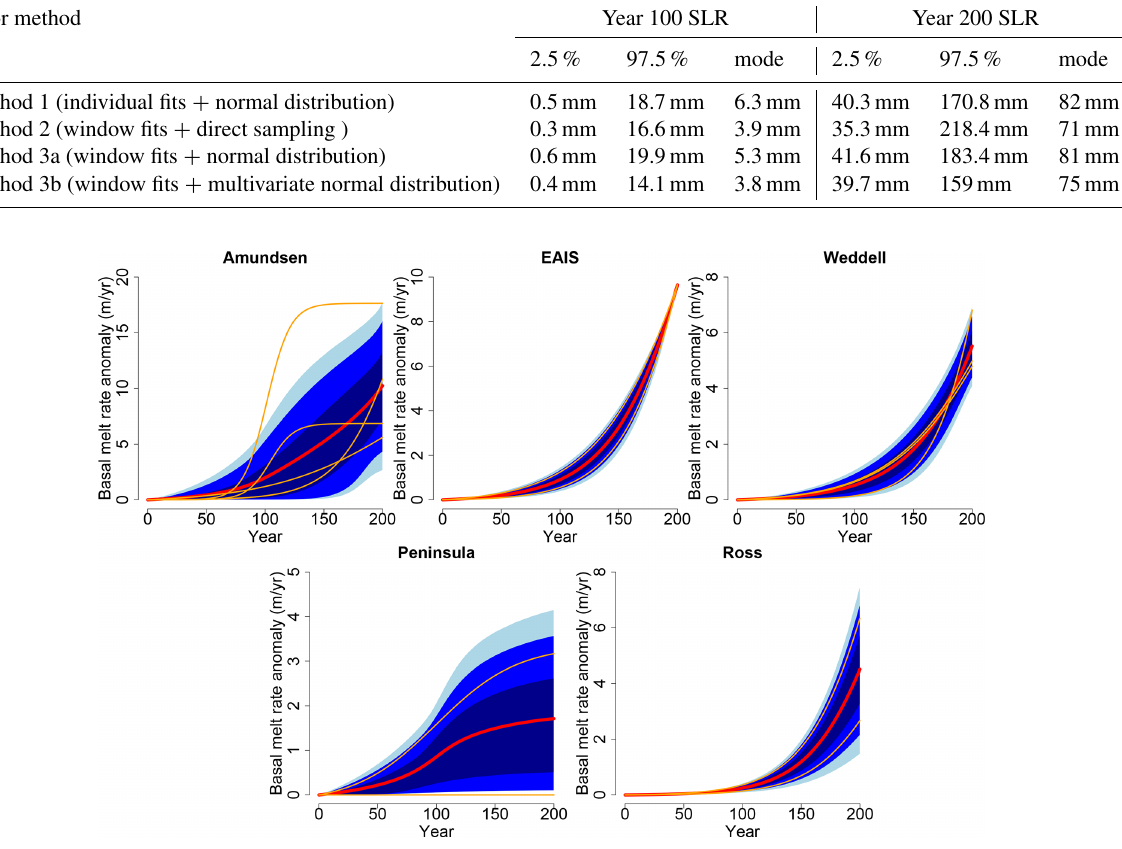
Figure 10. Prior basal melt rate anomaly (m/yr) trajectories generated with Method 1 (individual fits + normal distribution) as seen by CISM for each region: Amundsen Region, East Antarctic Ice Sheet (EAIS), Weddell Region, Antarctic Peninsula, and Ross Region. Red lines show mean of distribution; blue-shaded zones correspond to 50%, 80%, and 90% confidence intervals (from dark blue to blue to light blue, respectively); orange lines correspond to best fits to ocean model data. Note the different y -axis range for each